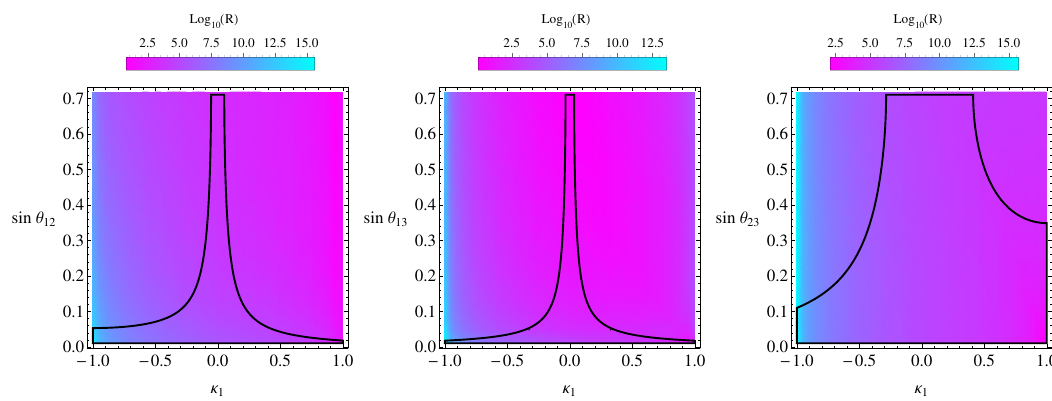
Figure 14. Correlation of dark pion lifetimes and departure from the (cid:13)avour aligned limit. The ratio between the longest and shortest dark pion proper lifetime is denoted R and shown by the heat map, for each of the scenarios de(cid:12)ned in eqs.(4.3){(4.5). The regions enclosed by the black curves are allowed by meson mixing constraints. The dark pion and mediator masses are set to m (cid:25) = 10 GeV, m X = 1 TeV, such that constraints from (cid:1) F = 1 decays are absent. D